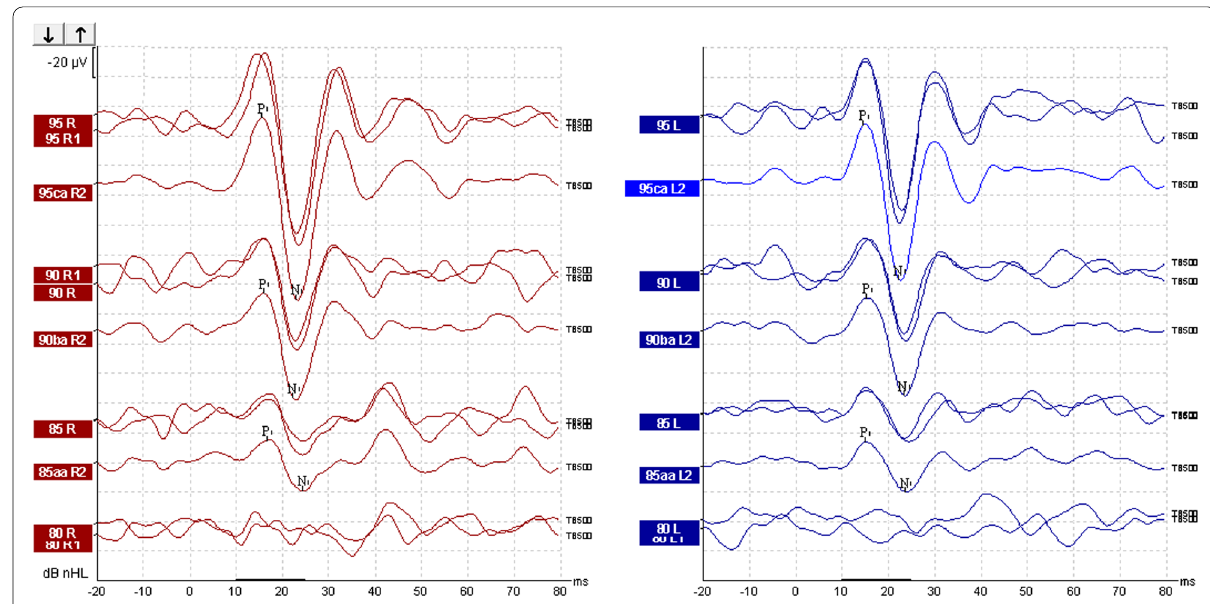
Fig. 1 Air conducted cVEMPs responses were obtained from a male individual. (AC cVEMPs responses, right and left ear VEMPs threshold 85 dB